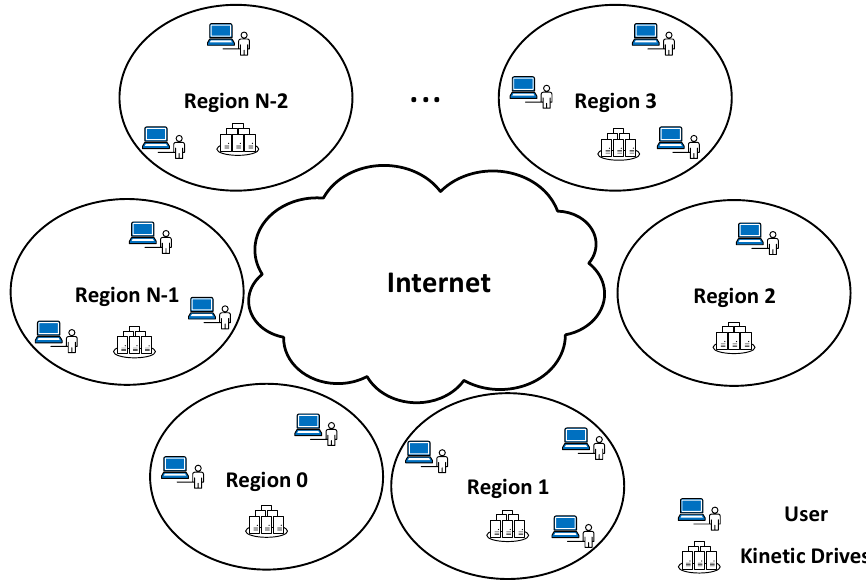
Figure 5. A novel global key-value store system based on Kinetic